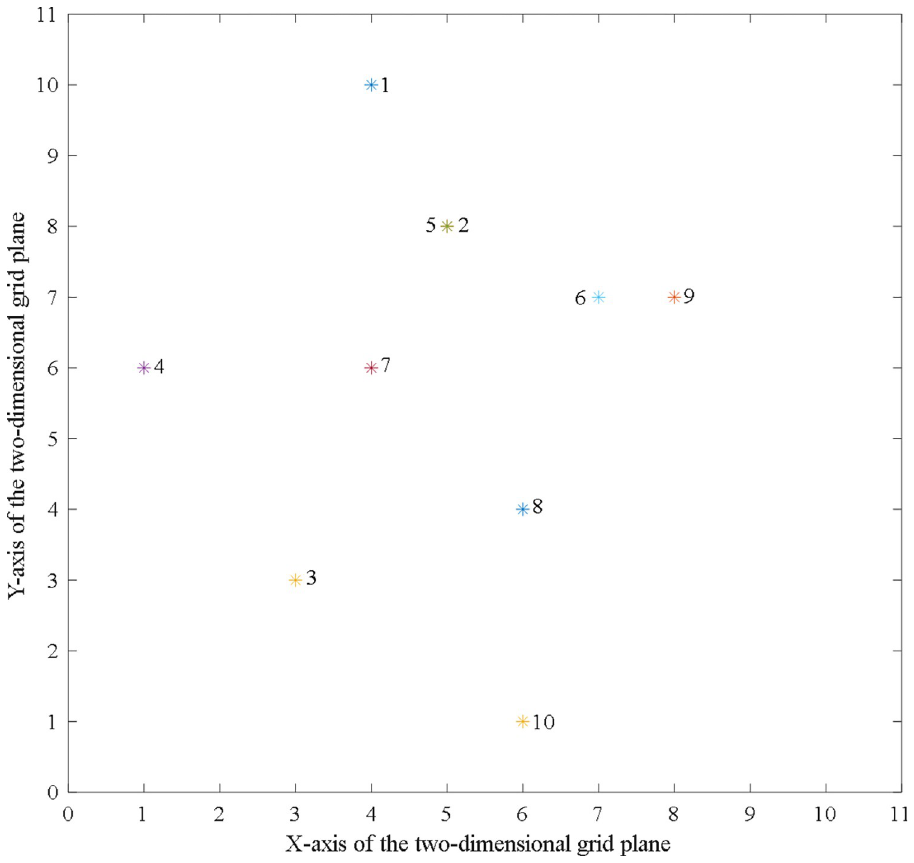
Fig 4. The initial location distribution of process routes to be